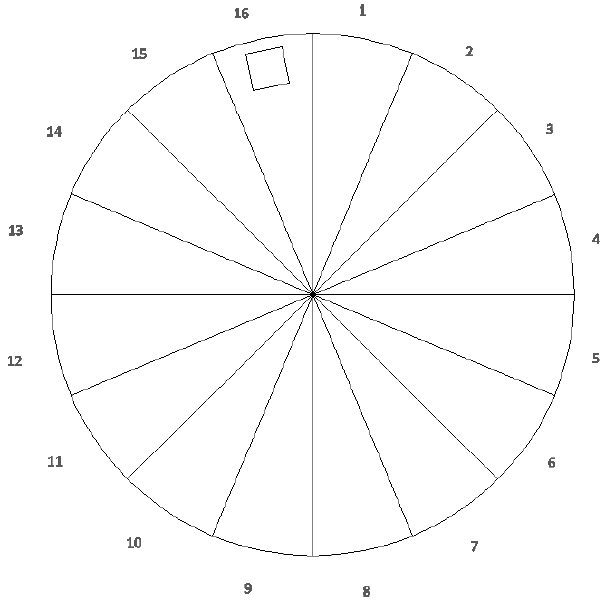
Figure 1 : Schematic drawing illustrating the subdivision of one of the six filter samples Figure 1. Schematic drawing illustrating the subdivision of one of subjected to the intercomparison. The square in sector 16 illustrates the 1.0 cm 2 punch taken the six filter samples subjected to the intercomparison. The square in sector 16 illustrates the 1.0cm 2 punch taken from each of the 16 from each of the 16 sectors pr. filter sample to perform a homogeneity test of the filter samples. sectors per filter sample to perform a homogeneity test of the filter Each of the sectors sent out to the participating laboratories had an exposed filter area of 8.6 samples. Each of the sectors sent out to the participating laboratories cm 2 ; i.e., when accounting for the removal of the 1.0 cm 2 punch. had an exposed filter area of 8.6cm 2 , i.e. when accounting for the removal of the 1.0cm 2